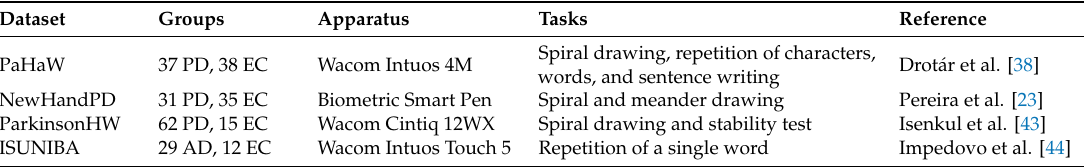
Table 1. Datasets (PD = Parkinson’s disease; AD = Alzheimer’s disease; EC = elderly